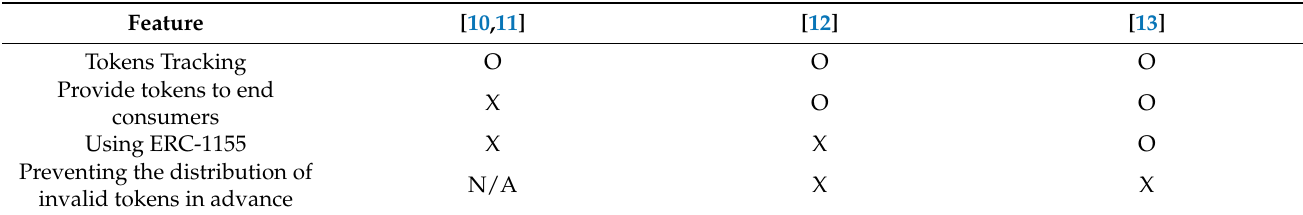
Table 1. Compare related